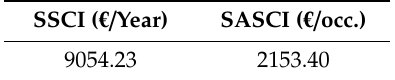
Table 7. SSCI and SASCI for the network under